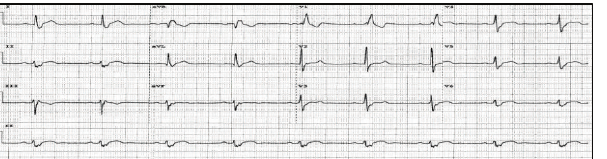
Figure 2: Patient’s 12-lead electrocardiogram when he presented with frequent lightheadedness. The tracing revealed sinus brady- cardia with first degree atrioventricular block, right bundle branch block, and left axis deviation consistent with left anterior fascicular block (new finding).